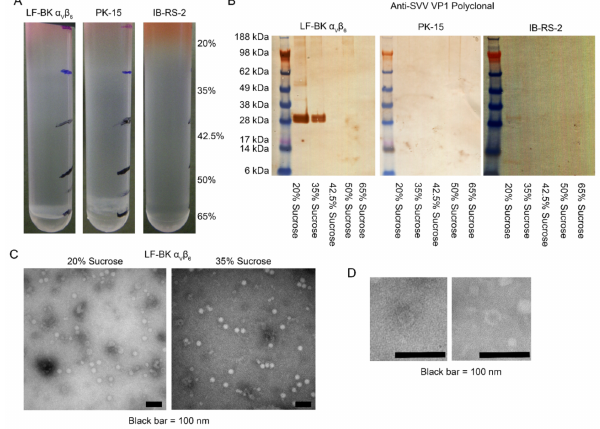
Figure 1. Supernatant from an IB-RS-2 flask inoculated with a submitted field sample cultured in three porcine-derived cell lines, LF-BK α V β 6 , PK-15, or IB-RS-2. ( A ) PEG precipitated supernatant was applied to discontinuous sucrose gradients ranging in density from 20% to 65% and demonstrated diffuse materials at all densities. ( B ) Western blotting of harvested gradient layers demonstrated strong SVA antigen in 20% and 35% fractions from LF-BK α V β 6 cultured samples and weak antigen in the 20% fraction for PK-15 and IB-RS-2 cultured samples. ( C ) The 20% and 35% fractions from the LF-BK α V β 6 gradient were examined by transmission electron microscopy using negative staining, and viral particles were observed. Both samples contained particles of the expected size for SVA. ( D ) The 20% fraction also contained structures resembling empty SVA